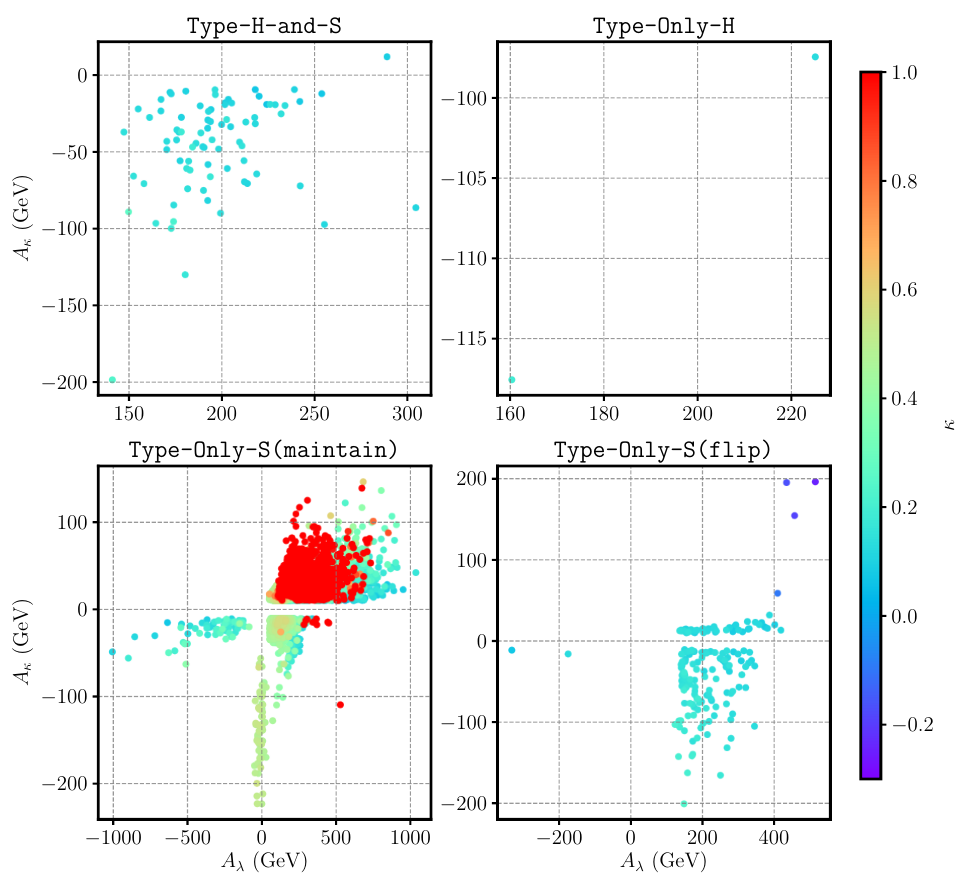
Figure 12 . ( A (cid:21) ; A (cid:20) ) for samples for which the strongest FOPT does not end in the SM vacuum. The points are colored by the (cid:20)